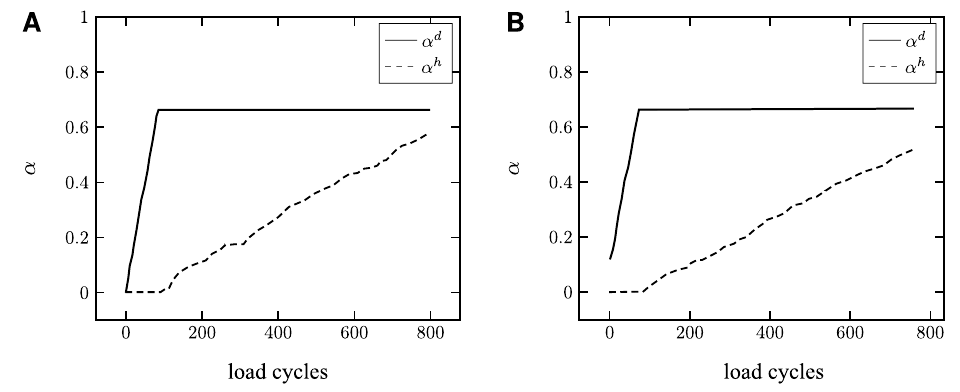
Fig. 10. Evolution of internal variables ( α d ) and ( α h ) for element 1 (A) and for element 2 (B) along the load cycles – initial damage.